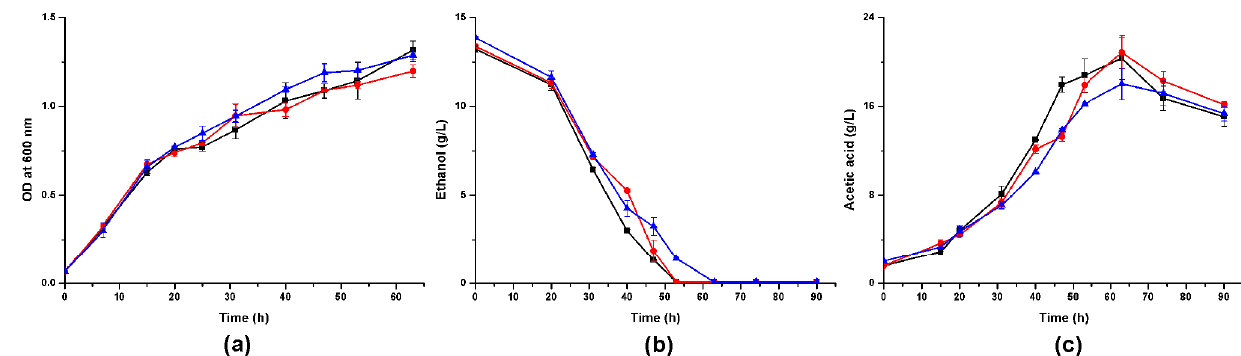
Figure 4. Time course of the cell growth ( a ), ethanol consumption ( b ), and acetic acid production ( c ) in YPG media containing 2% ethanol by A. pasteurianus CICC 22518 (square), 22518- ∆ alsS1 (circle), and 22518- ∆ alsS2 (uptriangle). Data were expressed as mean ± standard errors of three replicates.